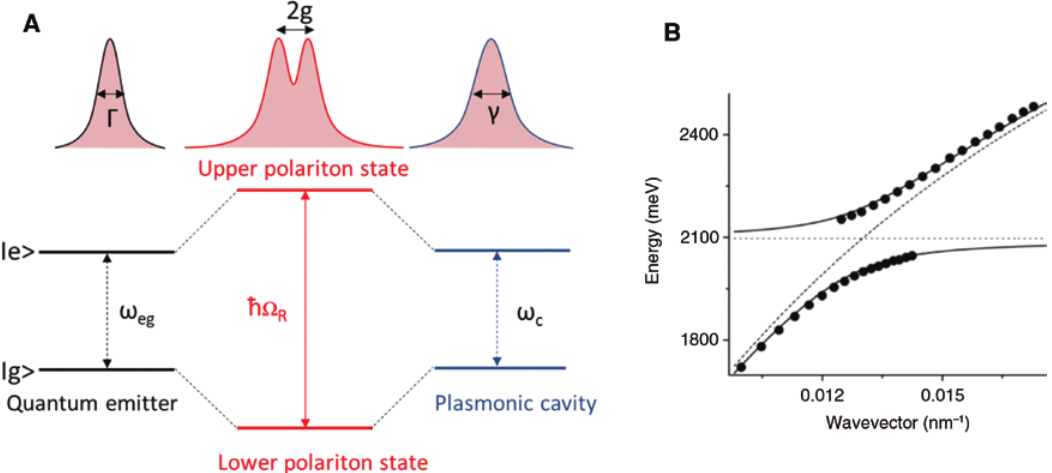
Figure 4: Principles of strong coupling. (A) Schematic of resonance interaction between a two-level QD and a confined electromagnetic field in a PC, which results in two new hybrid = 2 g ). Upper panel: manifestation of strong coupling between QDs and a PC in the experimentally states separated by Rabi splitting (ħ Ω R observable spectrum, splitting of the spectrum. (B) Anti-crossing behavior of a strongly coupled system consisting of a silver film and a concentrated cyanine dye in a polymer matrix. The data points are the dip energies in reflectance spectra as a function of the wave vector. The dashed and dotted lines represent the dispersion relation of the uncoupled surface plasmon and the exciton energy of the cyanine dye. The full lines are the calculated polariton energies. Panel (C) is reprinted with permission from Bellessa et al.